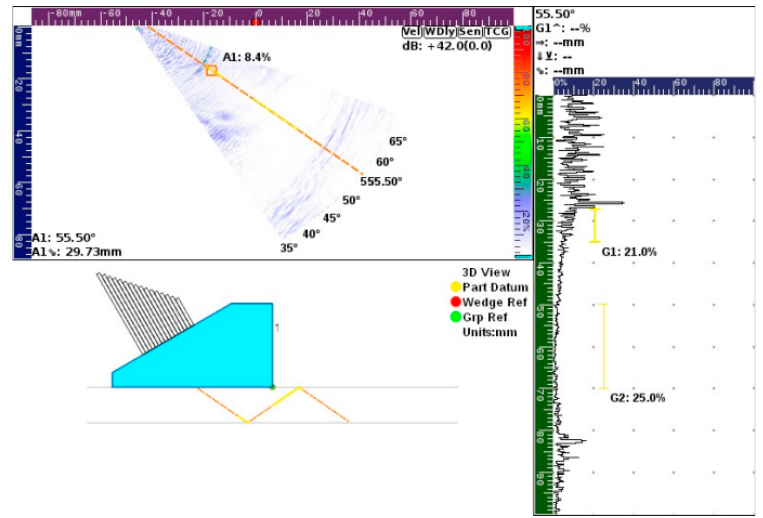
Figure 15. An example of a confident signal return detected using PAUT.